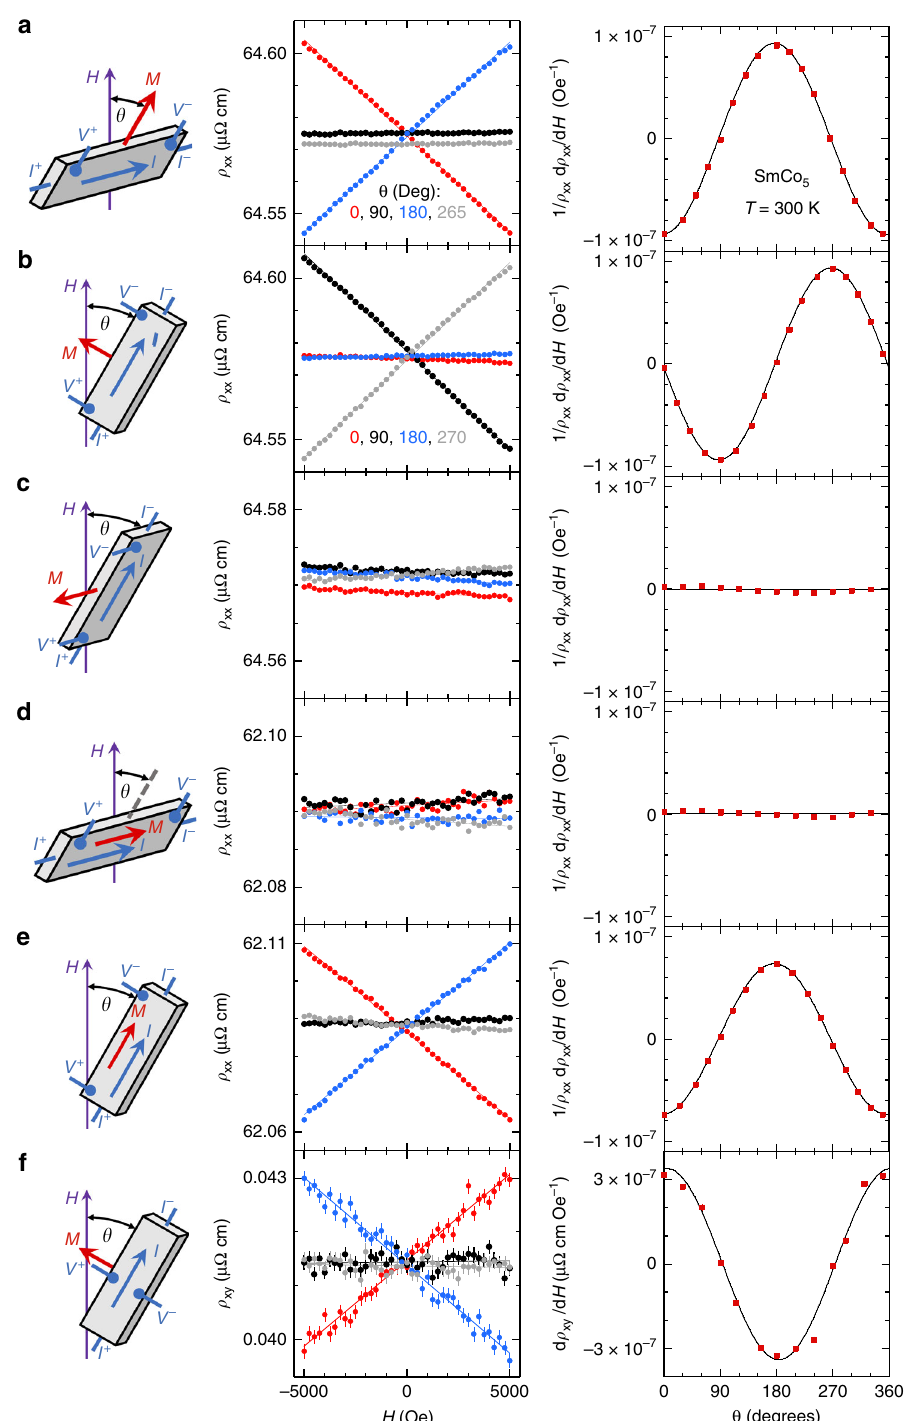
Fig. 2 Two mechanisms of antisymmetric magnetoresistance and the planar Hall effect. With two identi fi ed mechanisms to generate the antisymmetric linear MR behavior, six rotational scenarios ( a – f ) were designed to create various geometries between M , E , and H in order to test the functional forms of both ( M ⋅ H ) E and ( M × E ) × H . In each fi gure, we plot schematics of the rotation scenario, raw data ρ ( Η ) at major angular positions, and either the normalized linear slope 1/ ρ xx ( H = 0) d ρ xx /d H or the linear slope d ρ xy /d H vs. the rotation angle θ . Vertical error bars represent 1 σ s.d. uncertainty. Similar antisymmetric MR and rotation θ -dependence was also observed in another highly coercive magnet Nd – Fe – B (Supplementary Fig.